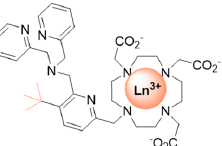
Figure 9. ParaCEST MRI contrast agents for zinc detection.